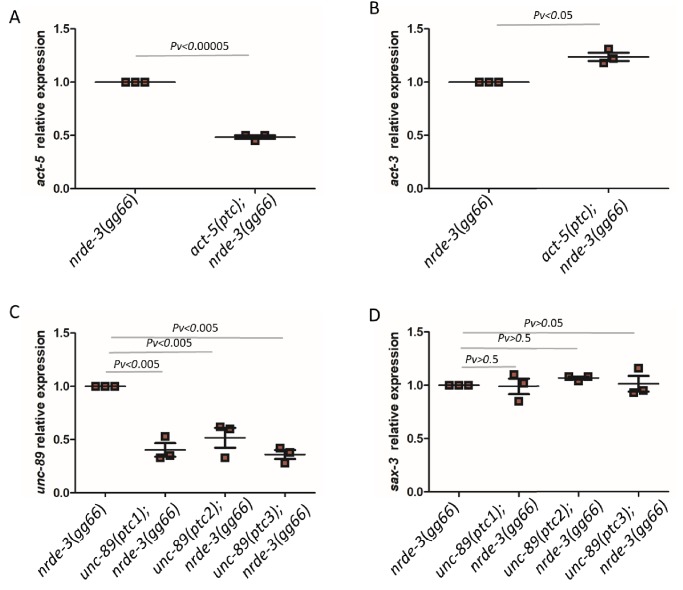
Partial data from double mutant analysis.qPCR analysis of act-5 (A) and act-3 (B) mRNA levels in nrde-3(gg66) mutants and act-5(ptc); nrde-3(gg66) double mutants as well as of unc-89 (C) and sax-3 (D) mRNA levels in nrde-3(gg66) and unc-89(ptc); nrde-3(gg66) double mutants. Single mutant nrde-3(gg66) expression levels are set at 1. Data are mean ± S.E.M.; average dCt values are shown in Figure 5—source data 1. Two-tailed Student’s t-test was used to calculate P values.